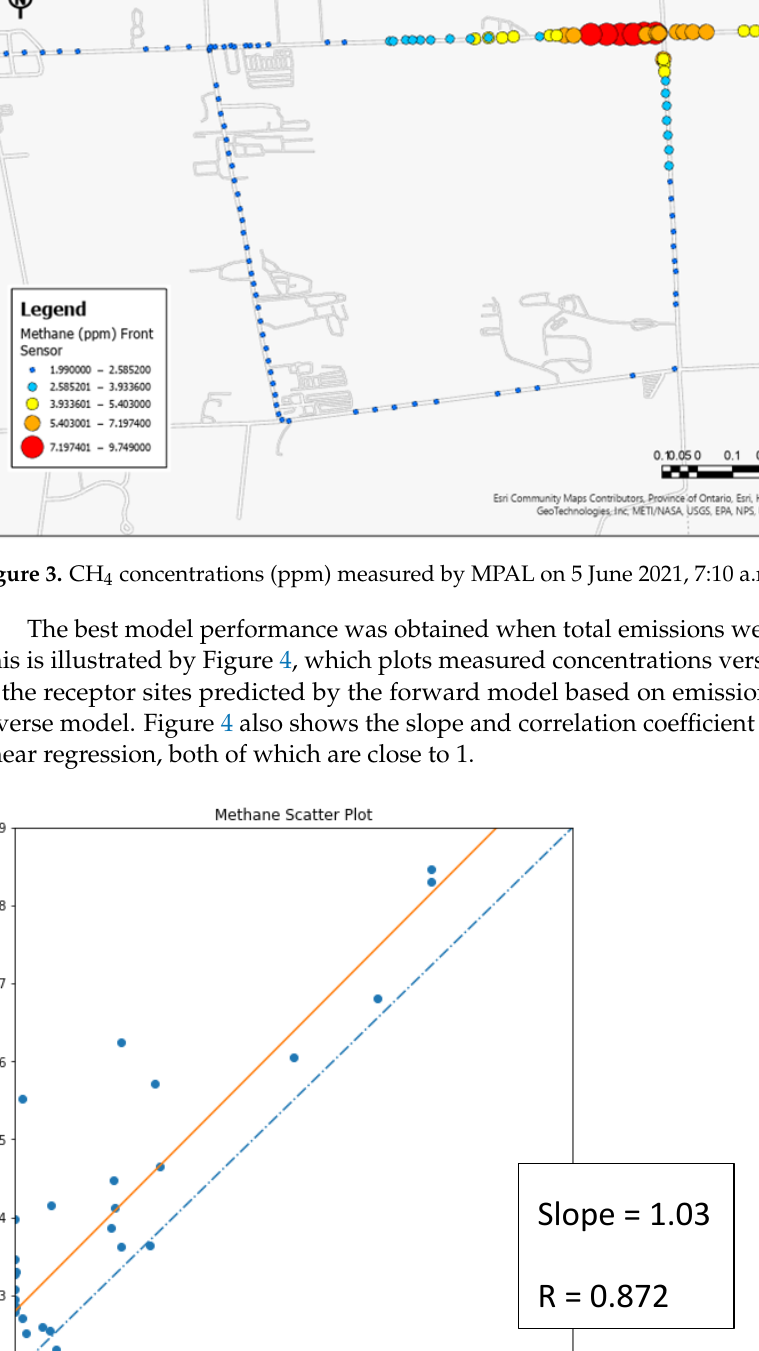
Slope = 1.03 R = 0.872